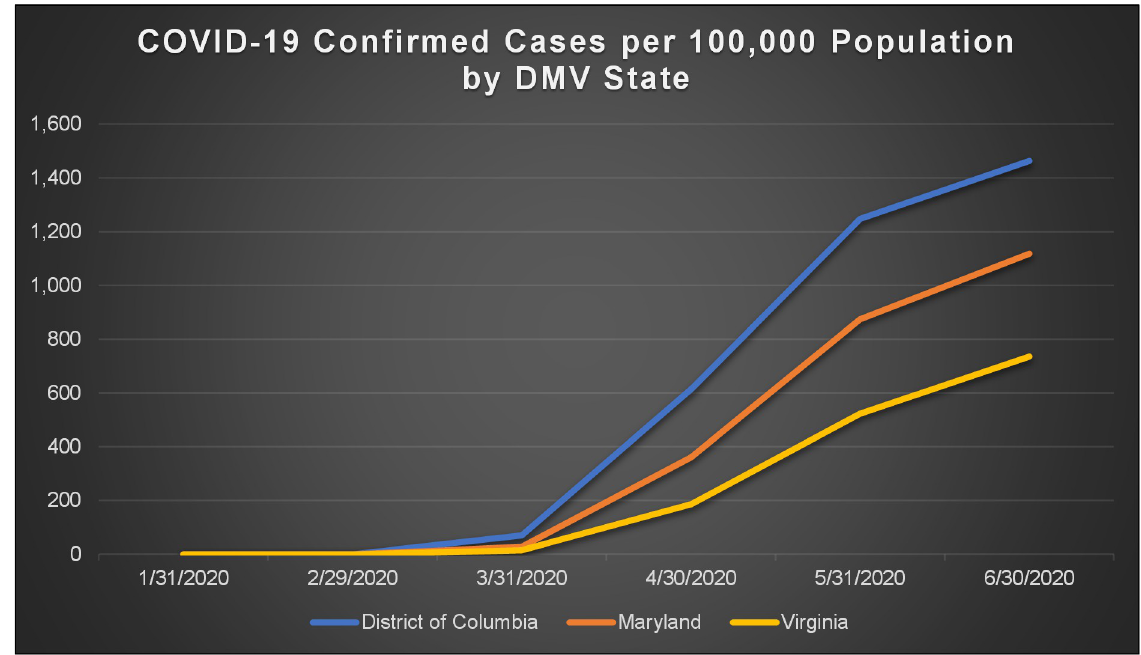
Fig 1. COVID-19 confirmed cases per 100,000 population by DMV